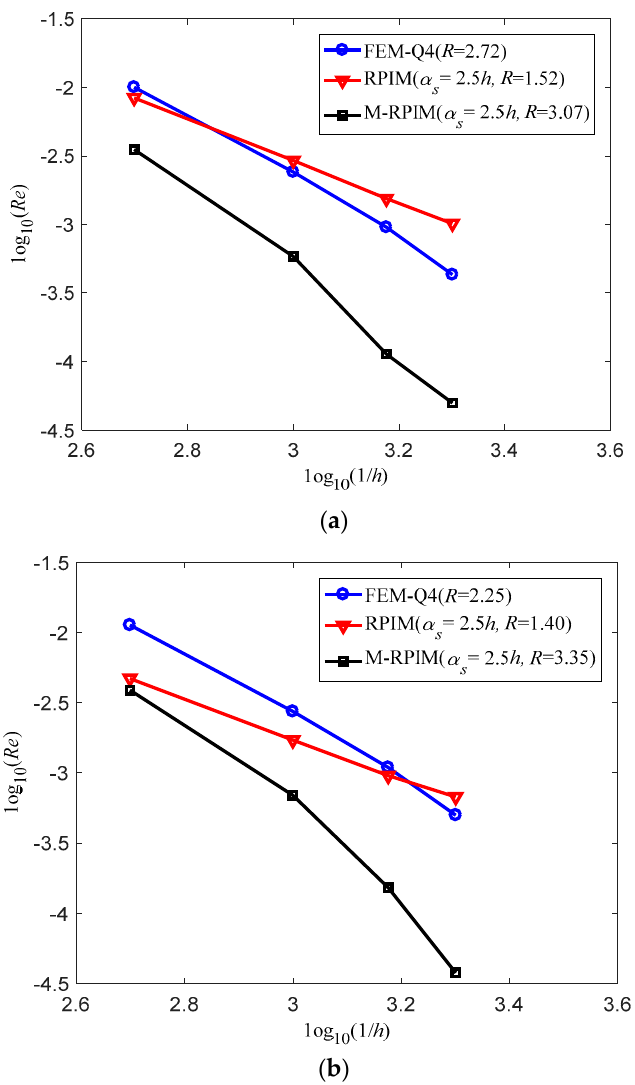
Figure 5. Comparison of the relative error (Re) results of the computed natural frequency values from different numerical methods versus the nodal interval (1/ h ): ( a ) Mode 1; ( b ) Mode 2.